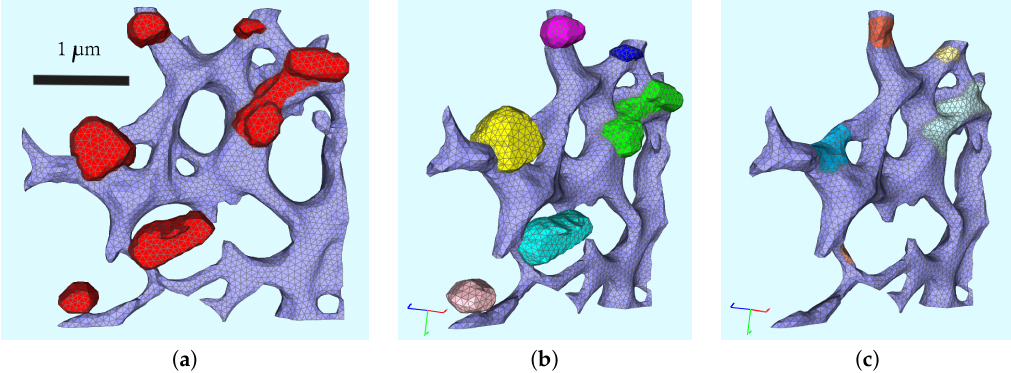
Figure 1. Small subsection of ER, surface grid. All surfaces together form the computation domain D . ( a ) ER surface and MW regions characteristics: E in blue, and W in red. ( b ) Subdomains of the surface model (geometry slightly rotated). Each web region represents its own subdomain. Ribosomes not visible because they are “hidden” behind the web regions. ( c ) Ribosomal regions visible due to undisclosed web regions. Note in ( b , c ): blue: E ; other colors: single MW regions W i and ribosomal regions R i , i = 1,2, . . .